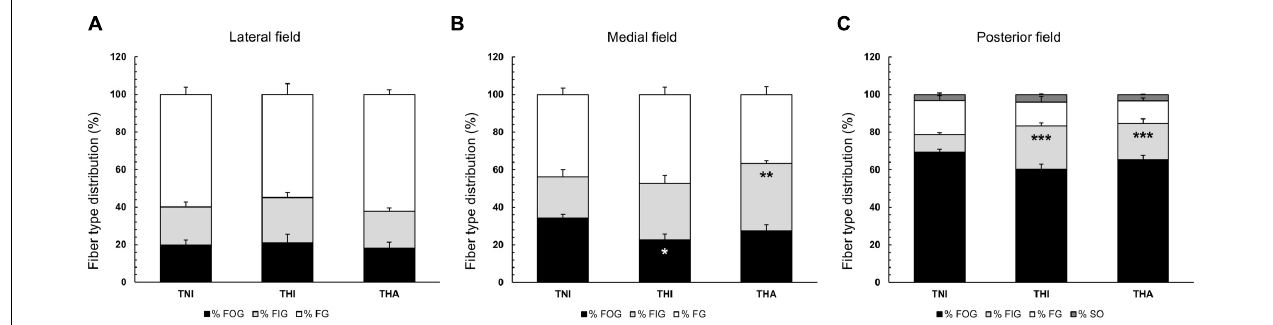
FIGURE 3 | Effects of intermittent hypobaric hypoxia (IHH) alone or in combination with light aerobic exercise on fiber type distribution in three TA muscle regions from trained rats ( A , lateral; B , medial; C , posterior). Fibers were classed as fast oxidative glycolytic (FOG), fast intermediate glycolytic (FIG), fast glycolytic (FG), or slow oxidative (SO, only present in the posterior field). ∗ , ∗∗ and ∗∗∗ indicate P < 0.05, P < 0.01, and P < 0.001, respectively, compared to TNI rats. TNI , trained normobaric inactive; THI , trained hypobaric inactive; THA , trained hypobaric